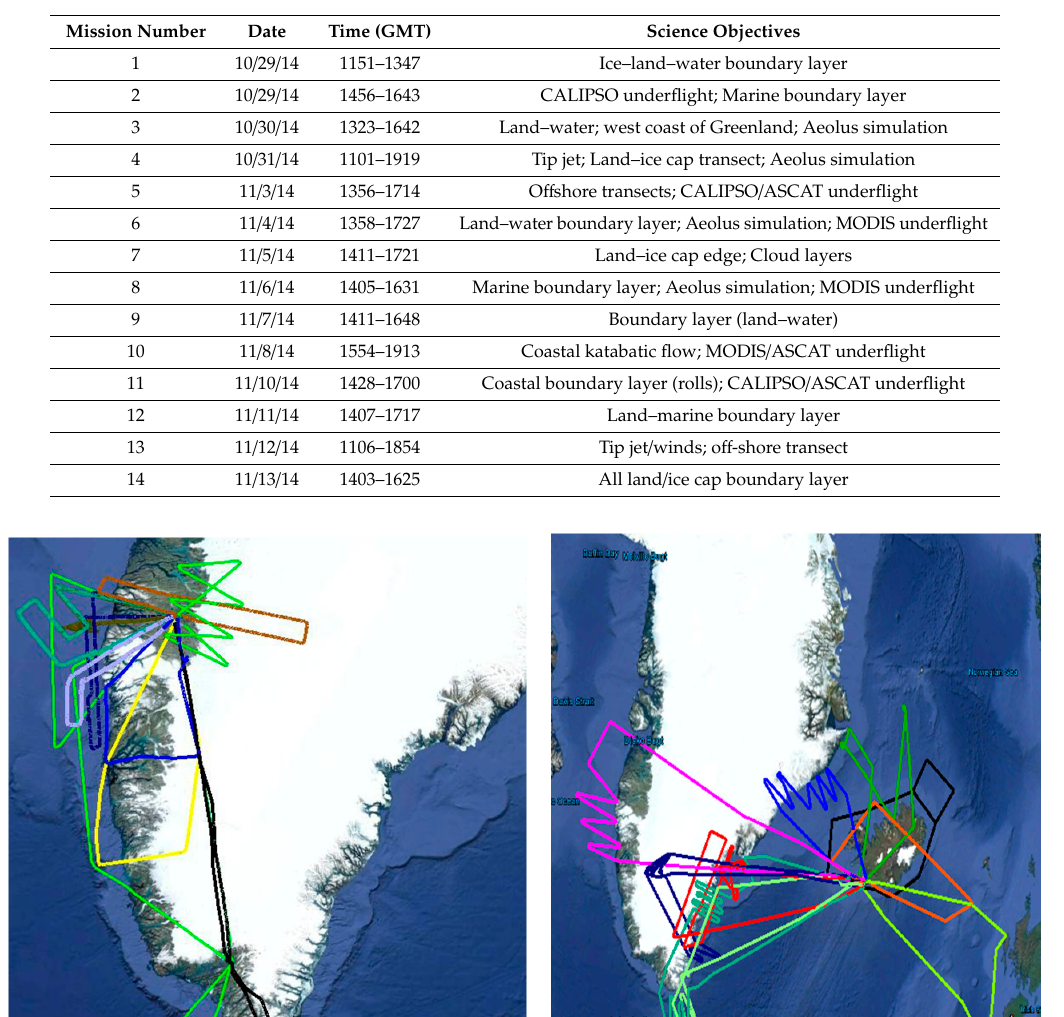
Table 1. Mission flights and science objectives during PW1.